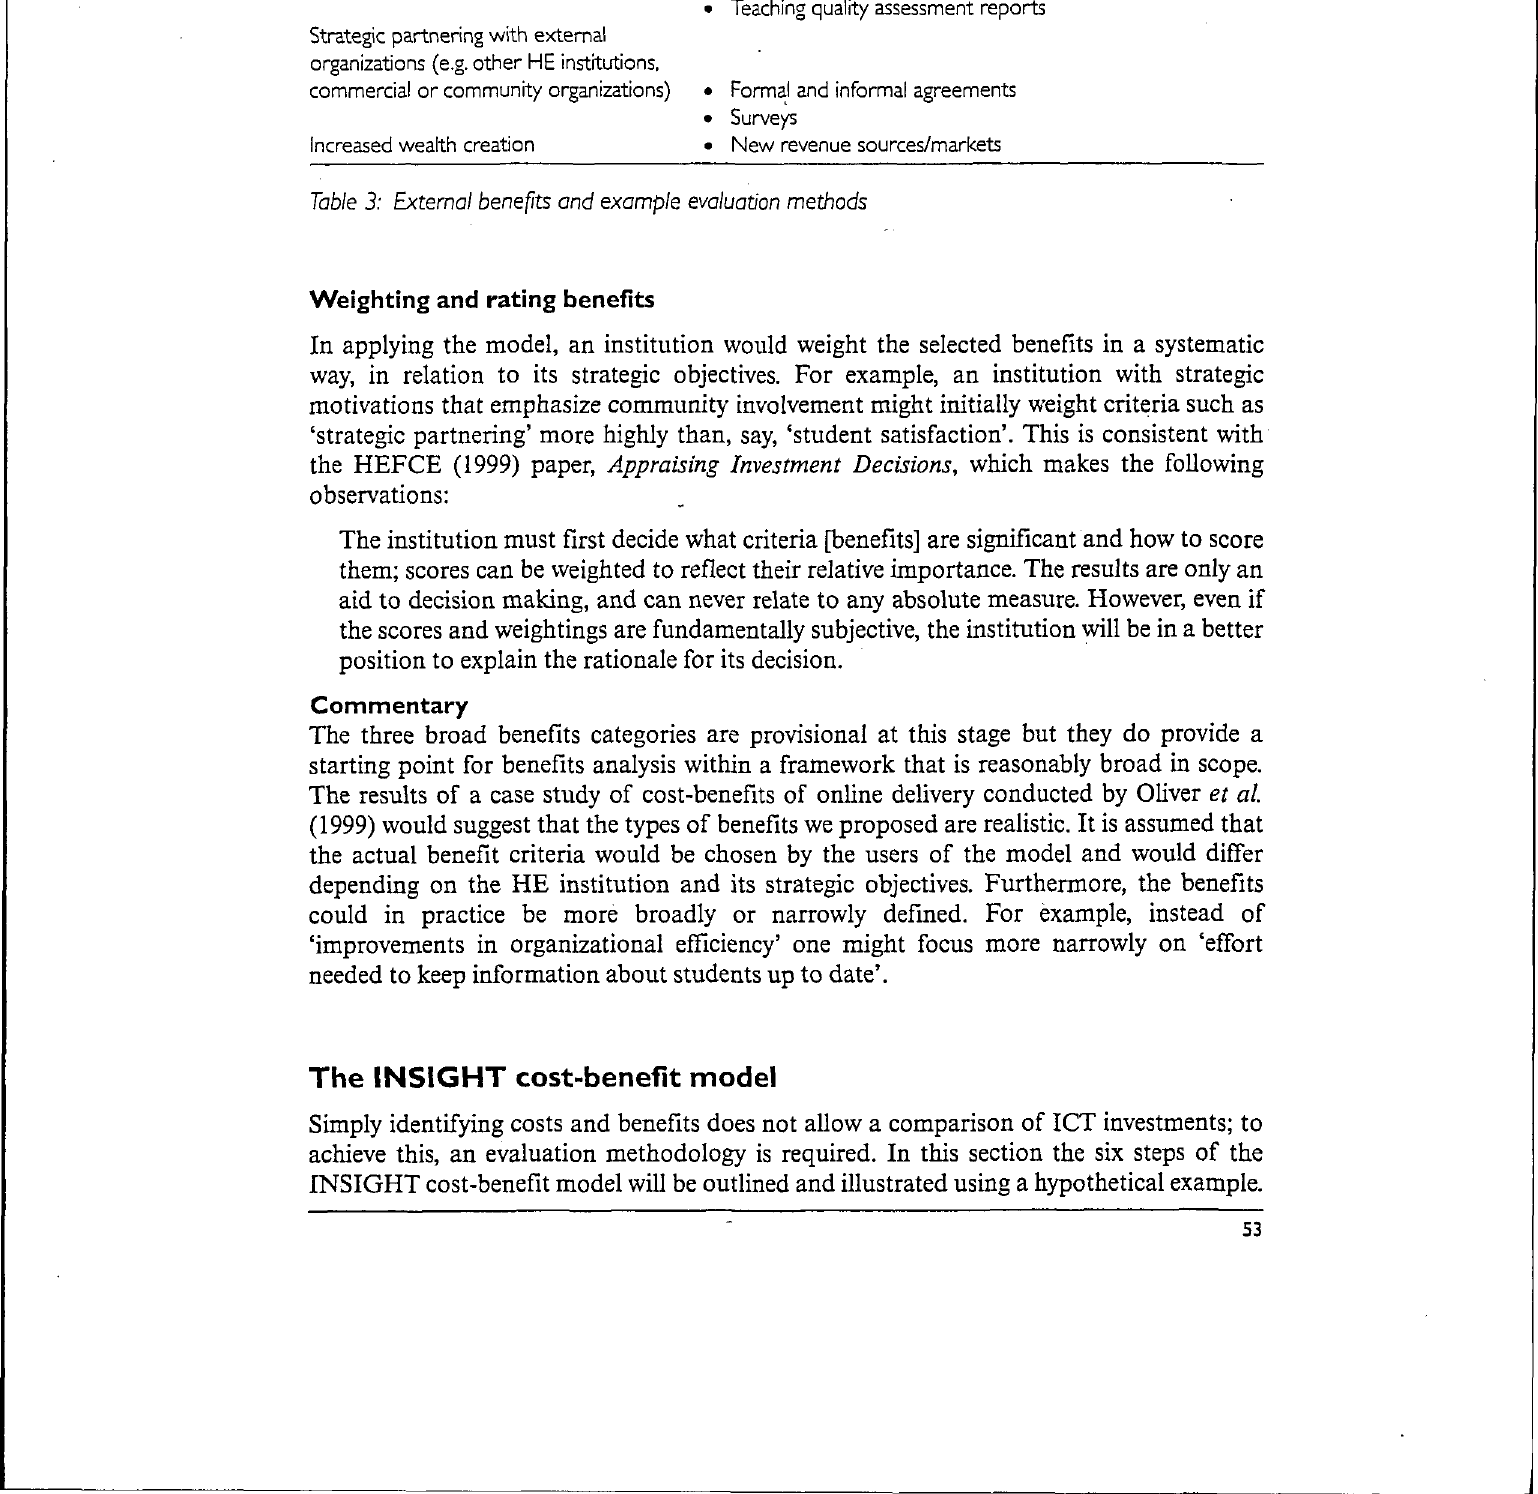
Table 3: External benefits and example evaluation methods